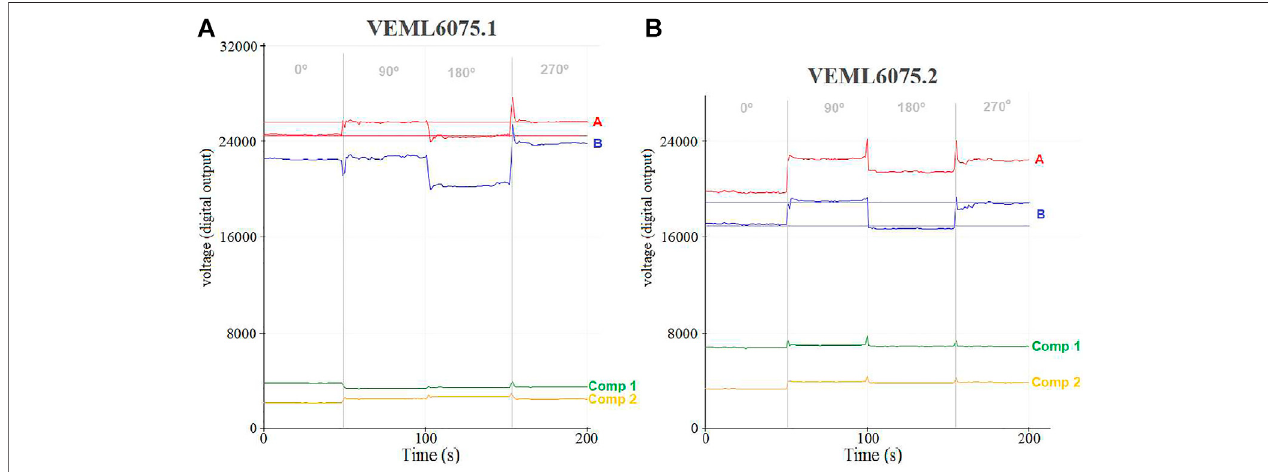
FIGURE 6 | Signal output of the sensors VEML6075.1 (A) and VEML6075.2 (B) once